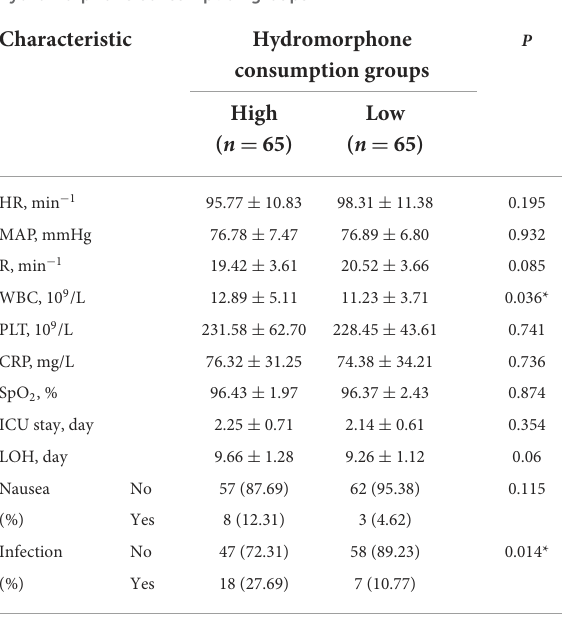
TABLE 3 Clinical characteristics between the infected and uninfected